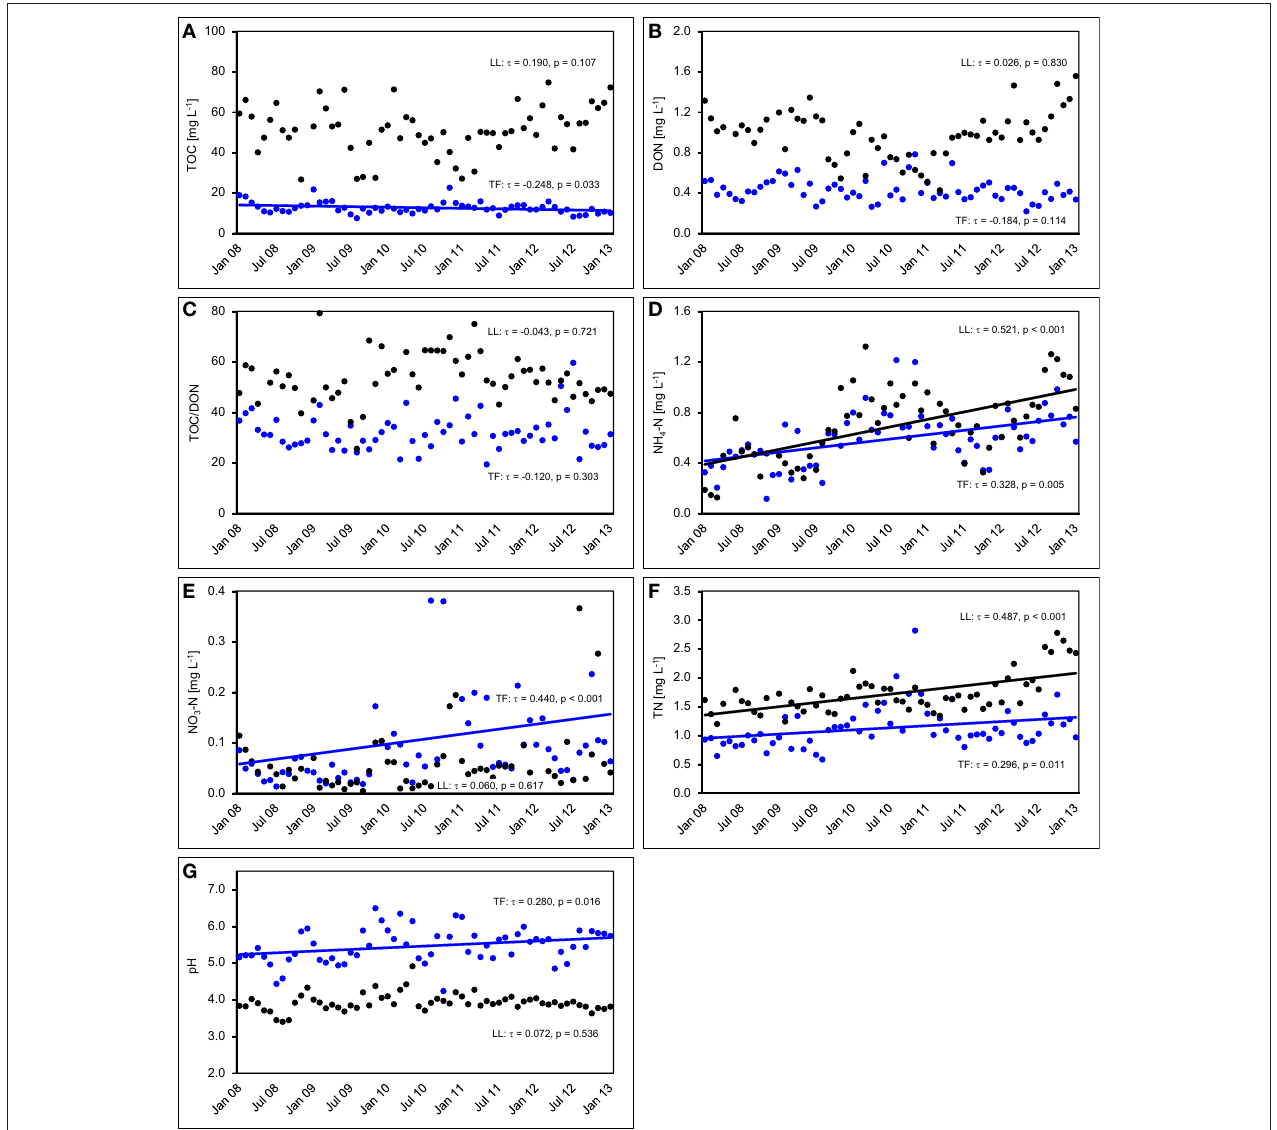
FIGURE 6 | Concentration time series in the control plots between January 2008 and December 2012. The figures show the course of volume-weighted, mean monthly values of (A) total organic carbon (TOC) concentrations, (B) dissolved organic nitrogen (DON) concentrations, (C) TOC/DON ratios, (D) concentrations of ammonium-N (NH 4 -N), (E) concentrations of nitrate-N (NO 3 -N), (F) concentrations of total nitrogen (TN), and (G) pH values in throughfall (TF, blue), and litter leachate (LL, black) of the control plots ( n = 4 ) of the nutrient manipulation experiment (NUMEX). Solid lines illustrate significant trends in the dataset ( p < 0.05 ).